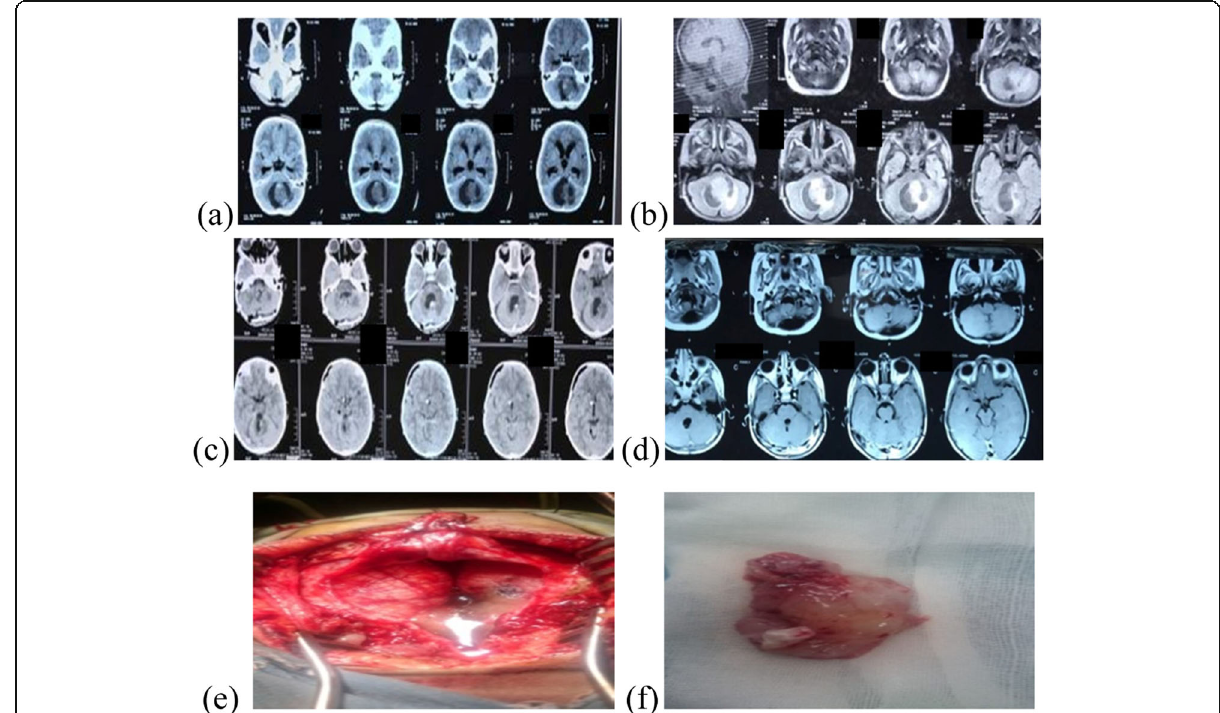
Fig. 3 a – f Male patient 2years old of pilocytic astrocytoma. a Preoperative CT brain. b Preoperative T1-weighted MRI brain axial images. c